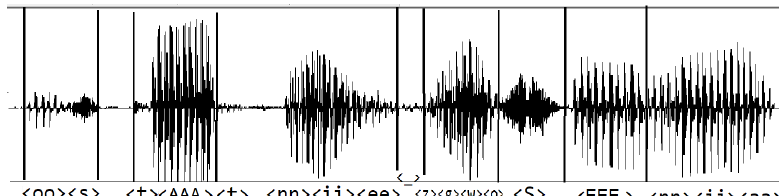
Figure 23. Illustration of phoneme labels being associated with signal frames of one training data by a human